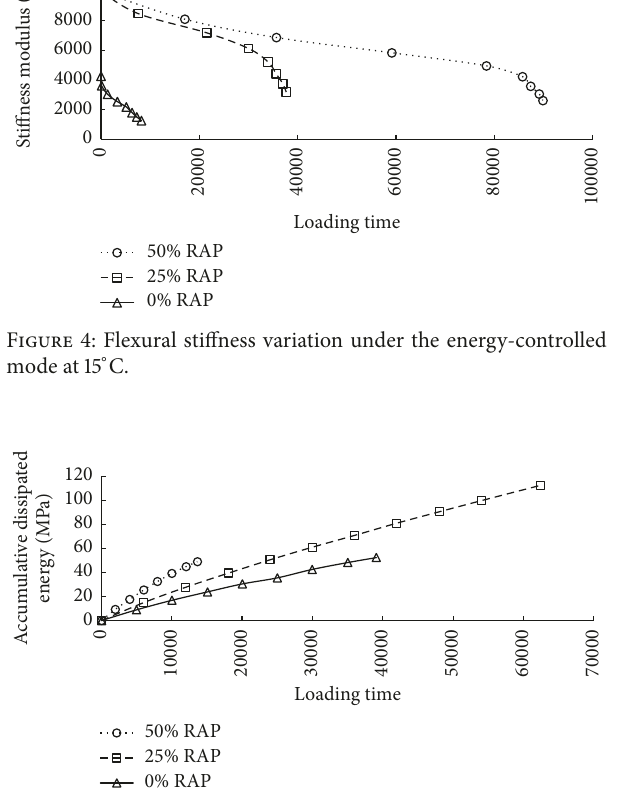
Figure 5: Accumulative dissipated energy variation under the strain-controlled mode at 15 ∘ C.